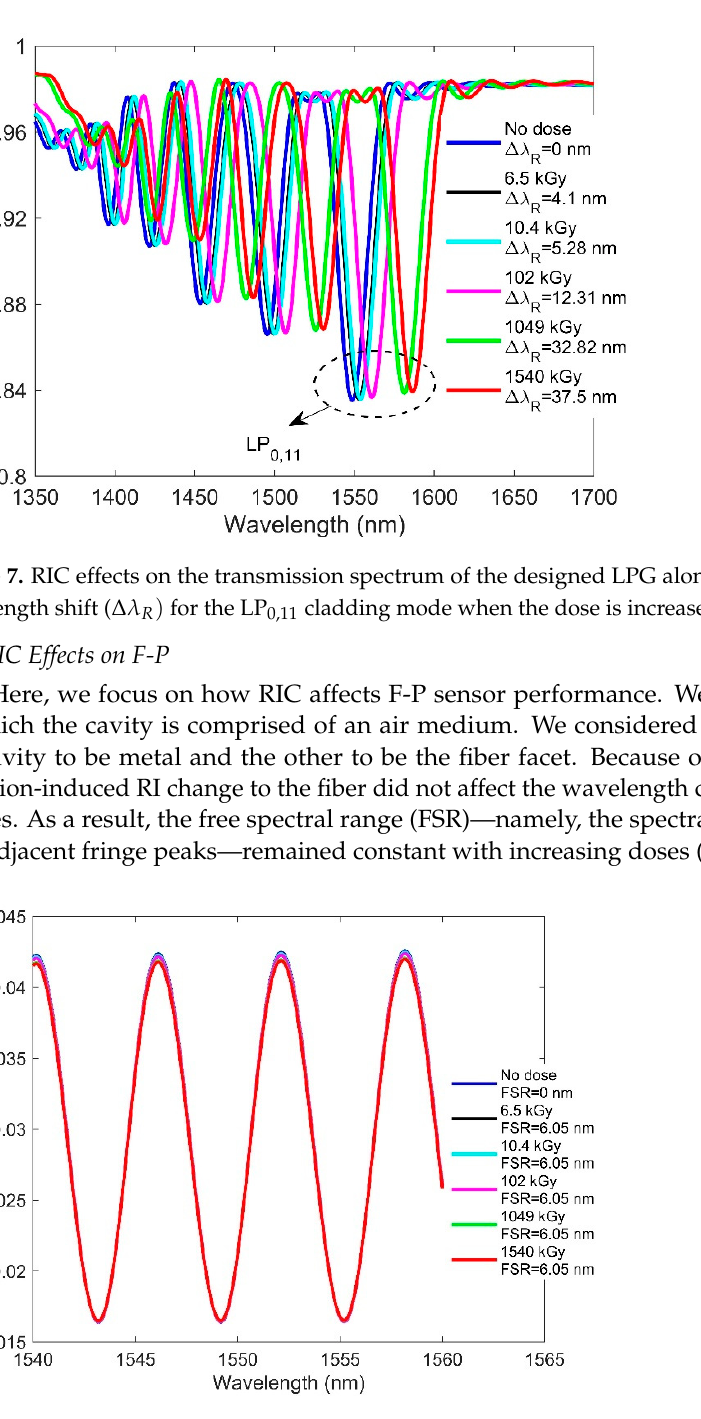
Figure 8. RIC effects on the interferometric fringes of the designed F-P when the dose is increased from 0 to 1540 kGy, where FSR is the spectral distance between two adjacent fringe peaks for a given radiation.